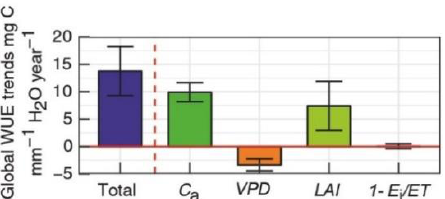
Figure 3. Contributions of key controlling factors to global WUE change. The error bars are standard deviation (Source: Cheng et al., 2017 [8]). Reprinted with permission. Adapted with permission from ref. [8] Copyright 2017 The author s .